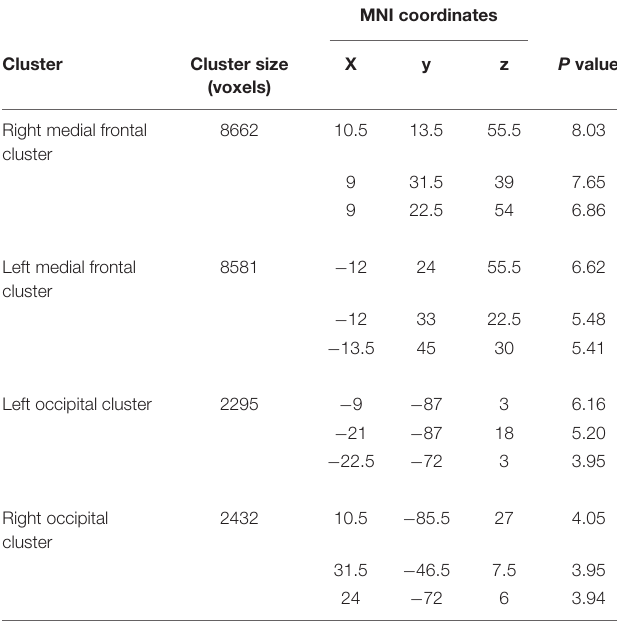
TABLE 2 | Brain regions in which participant P1 showed significant WM